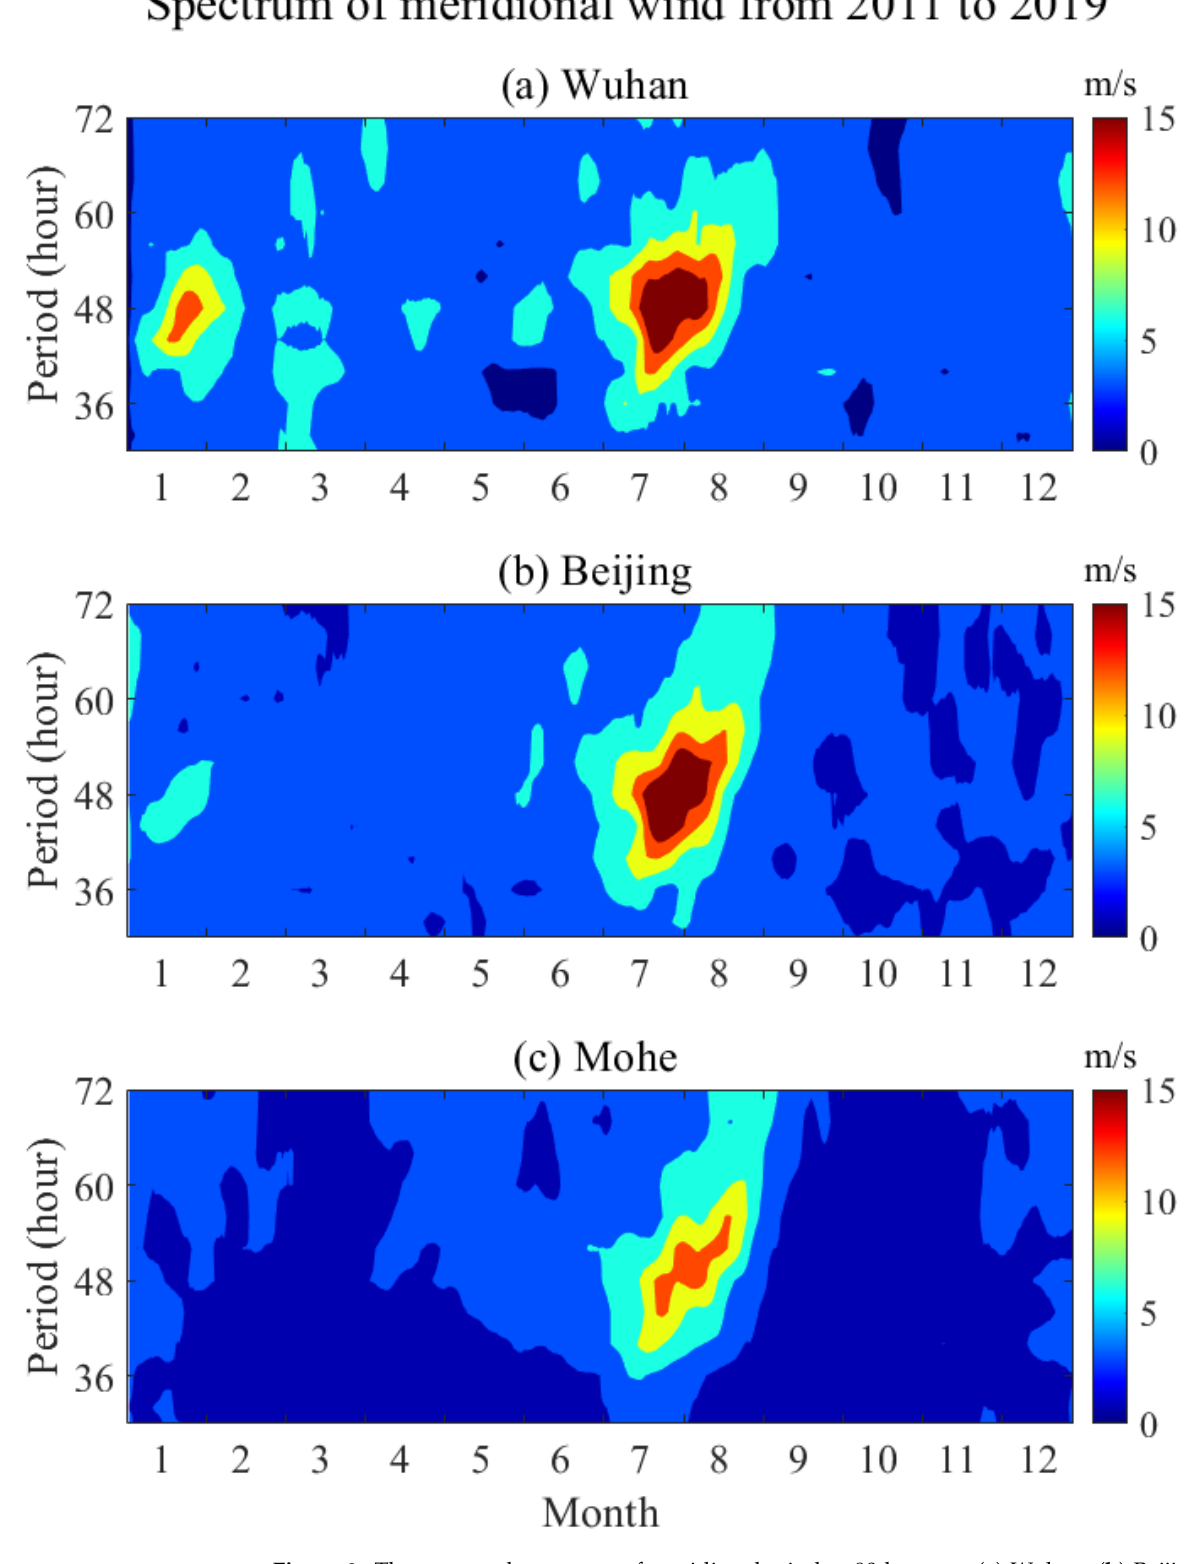
Figure 8. The averaged spectrum of meridional wind at 90 km over ( a ) Wuhan, ( b ) Beijing, and ( c ) Mohe from 2011 to 2019.